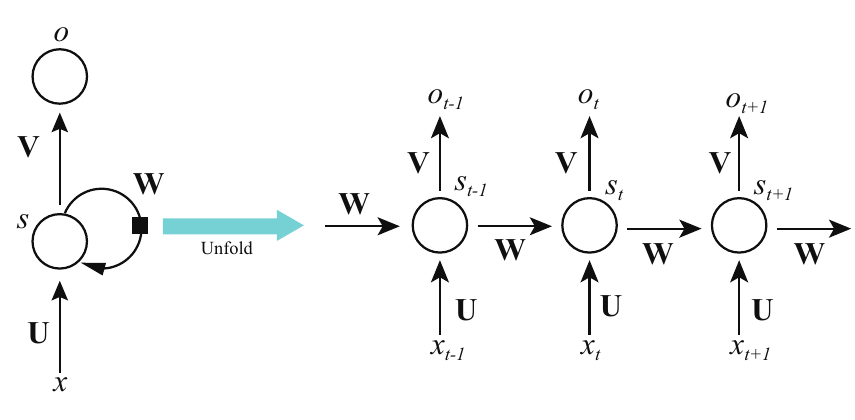
Figure 2. A simple RNN architecture with one hidden layer (recurrence using the previous hidden state). W , U , V are parameters for weights [23].